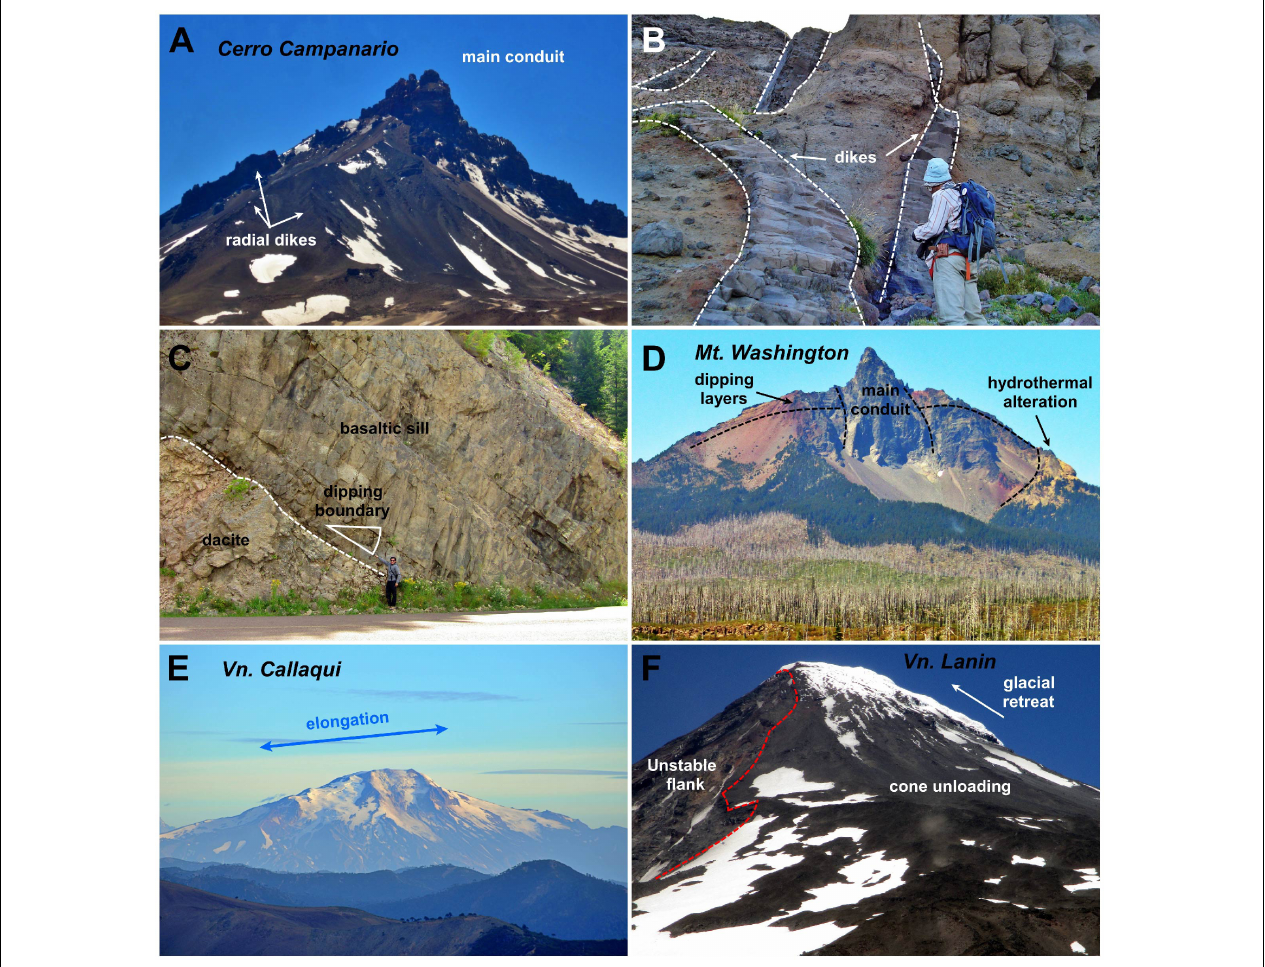
FIGURE 7 | Internal architecture of basaltic edifices. (A) Cerro Campanario and its radial dikes Chile; (B) Basaltic dikes intruding volcaniclastic sequences in the flanks of Callaqui volcano, Chile; (C) Basaltic sill intruding Cenozoic dacitic units at Clearwater Overlook, Washington (United States); (D) Internal structure and peripheral hydrothermal alteration at Mt. Washington (Cascades of Oregon, United States), a basaltic shield edifice; (E) Elongation of Callaqui volcano (Chile), lying over a transtensional fault system; (F) Glacial retreat at Lanin volcano (Chile), exposing the volcano structure (causing unloading) and increasing flank instability. Photos (B) by Gerd Sielfeld and the rest by Jorge